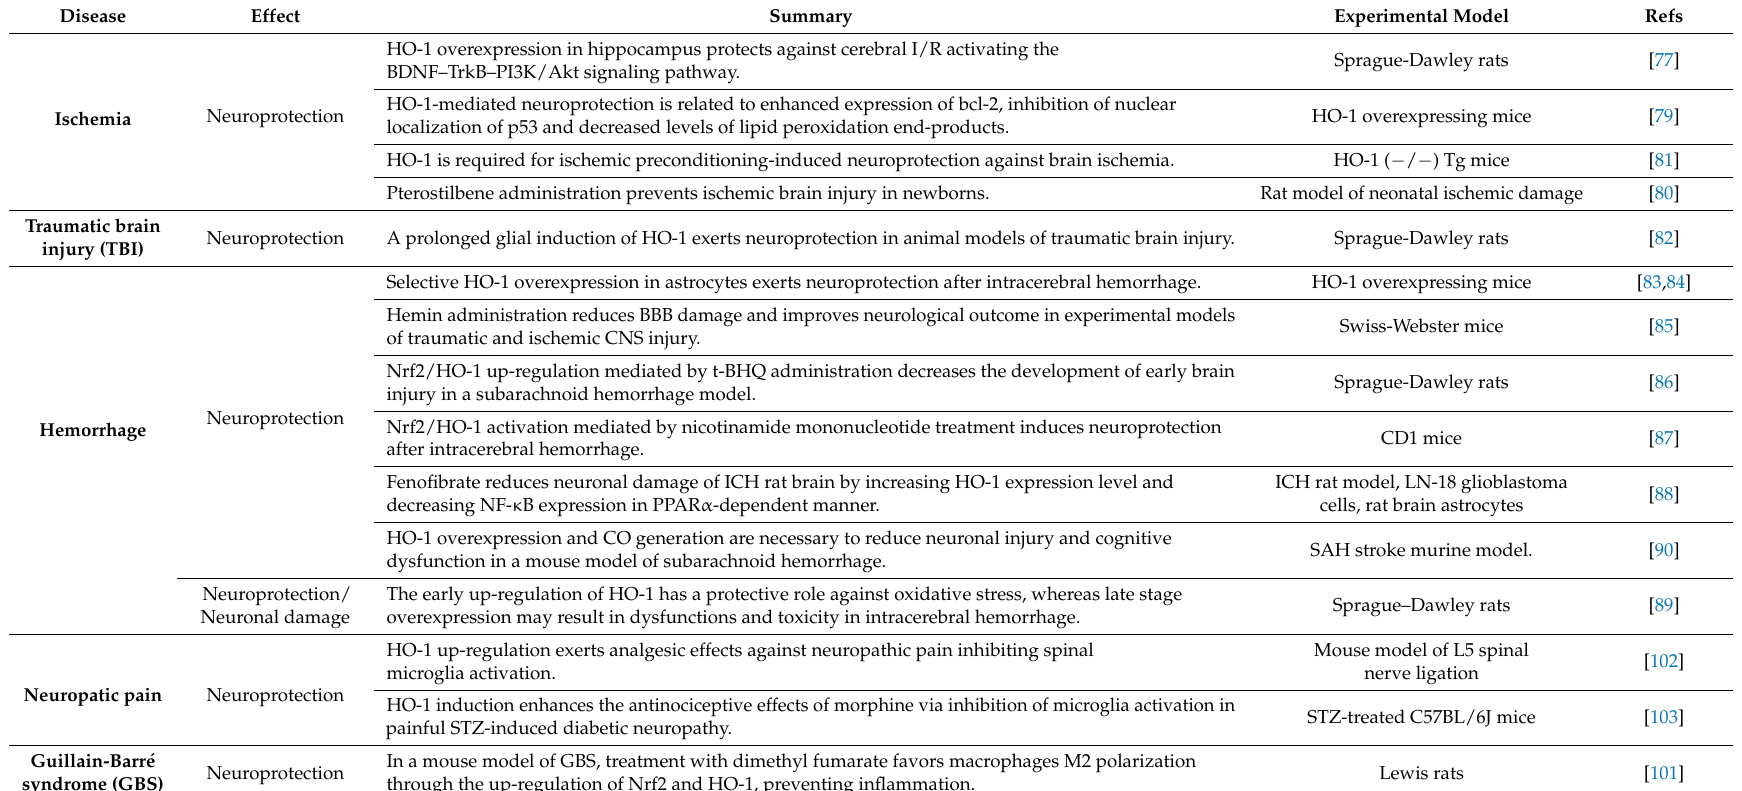
Abbreviations used in the table: 6-OHDA, 6-hydroxydopamine; AD, Alzheimer’s Disease; Akt, serine/threonine kinase; AMPK, AMP-activated protein kinase; ATR-I, atractylenolide-I; Bcl2, Anti-apoptotic factor B-cell lymphoma 2; BBB, blood brain barrier; BDNF, Brain-derived neurotrophic factor; BVR, biliverdin reductase; CART, cocaine- and amphetamine-regulated transcript; CNS, Central Nervous System; CO, carbon monoxide; DDC, 2 (cid:48) ,3 (cid:48) -dihydroxy-4 (cid:48) ,6 (cid:48) -dimethoxychalcone; EAE, experimental autoimmune encephalomyelitis; EPO, Erythropoietin; GBS, Guillain-Barr é syndrome; HO-1, heme oxygenase-1; I/R, ischemia/reperfusion; ICH, intracerebral hemorrhage; LPS, lipopolysaccharide; MAPK, Mitogen Activated Protein Kinases; MCI, Mild Cognitive Impairment; NB, neuroblastoma; NF κ B, nuclear factor kappa light- chain-enhancer of activated B cells; Nrf2, nuclear factor erythroid-derived 2-like 2; PD, Parkinson’s Disease; PI3K, phosphoinositide 3-kinase; PPAR α , peroxisome proliferator-activated receptors alpha; SAH, subarachnoid hemorrhage; STZ, streptozotocin; t-BHQ, tert-butylhydroquinone; TrkB, tropomyosinreceptorkinase